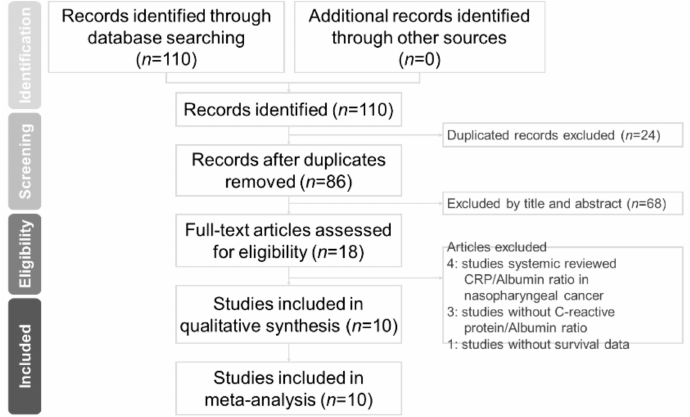
Figure 1. Flow diagram of study